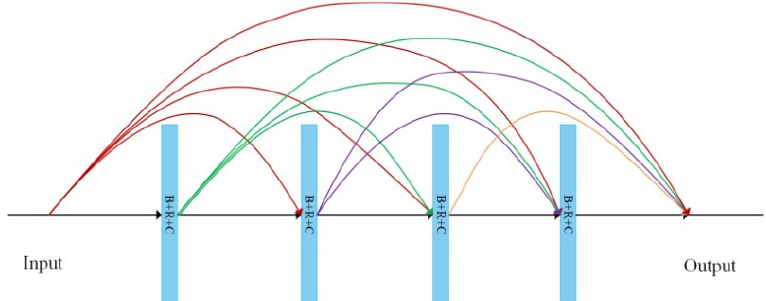
Figure 3. Architecture of a dense block with four layers. B + R + C: Batch normalization + ReLU + Convolutional layer (kernel size: 3 × 3, stride: 1).